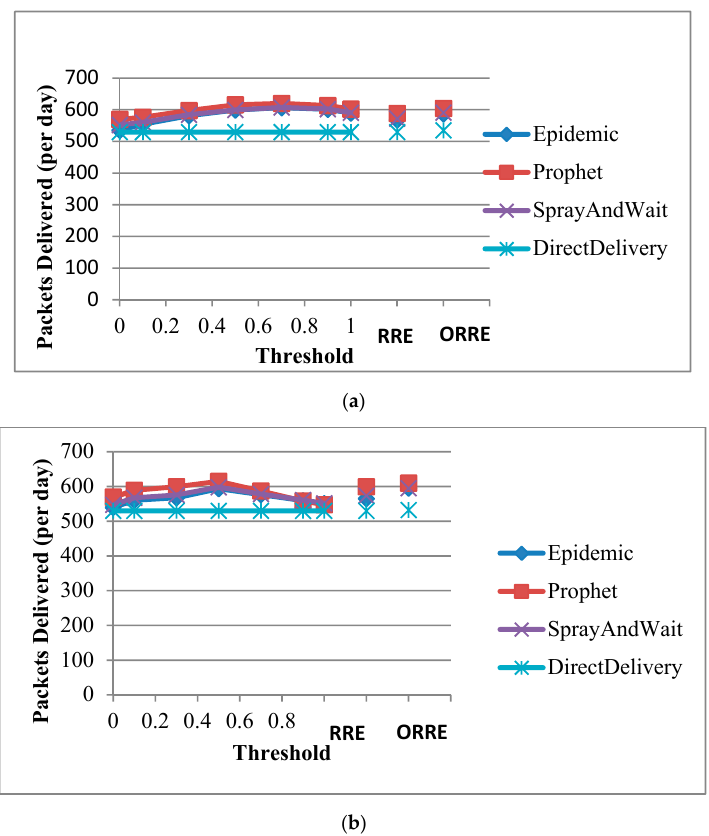
Figure 9. Packets delivered for 20 nodes and 3 base stations for ( a ) pigeon and ( b ) flying fox scenarios.